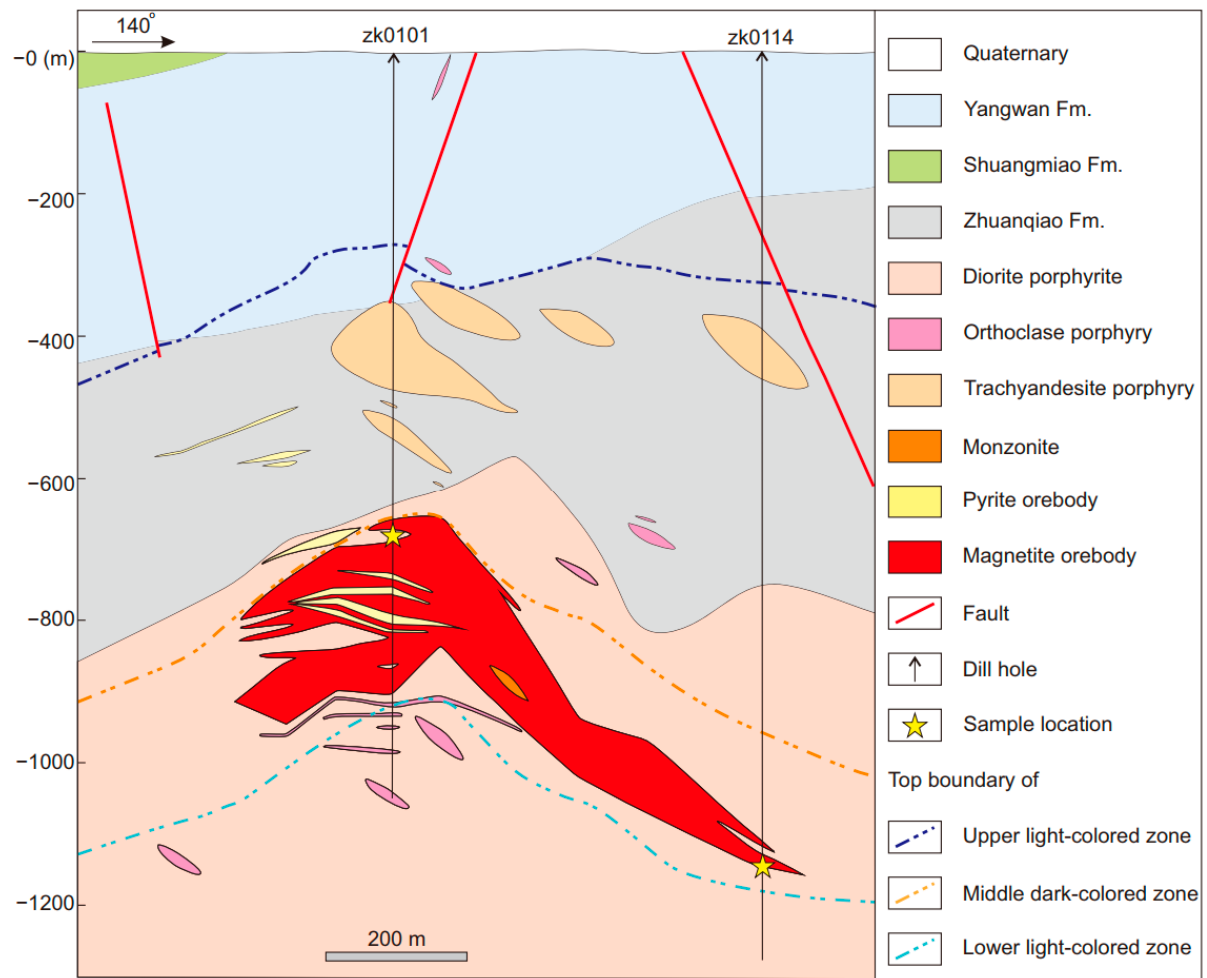
Figure 2. Geological map of Nihe IOA deposit (modified after [43]). Abbreviations: F.m = For- mation.